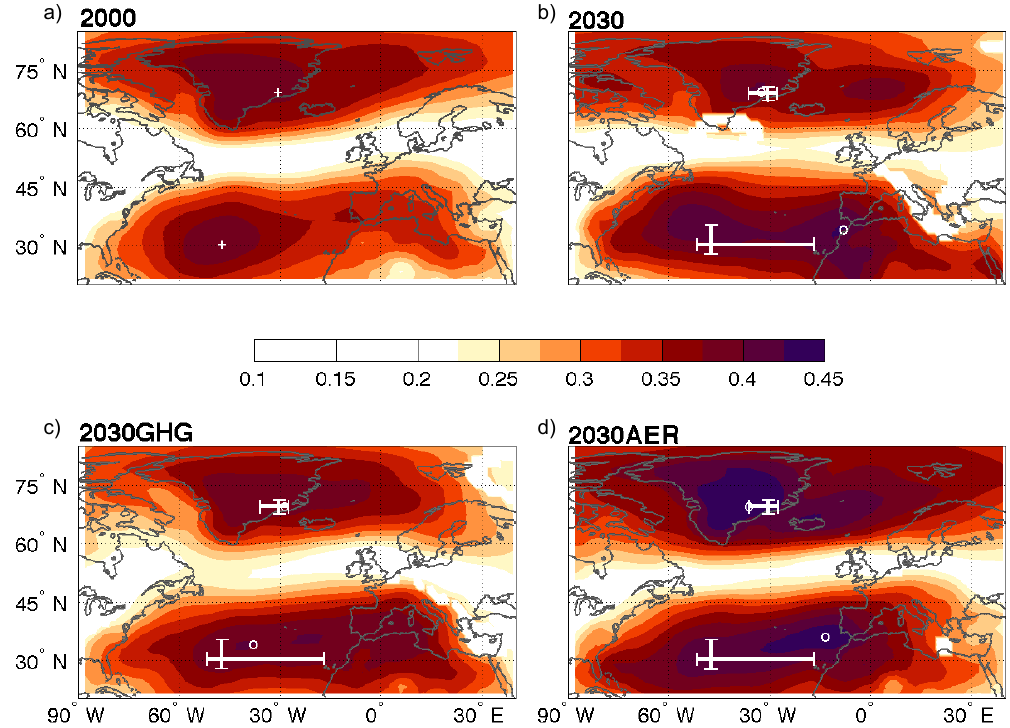
Figure 1. Sea-level pressure coherence index maps of the North Atlantic sector for the 2000 (a) and 2030 (b) simulations and the two sensitivity studies ( c , d ) in winter (DJF). The SLP centres of action (COAs) for the control run and for the 2030 simulations are shown by white crosses and white circles, respectively. The bars delimit the range between the 10th and 90th percentile of the CI maxima in the 2000 simulations. Only areas in which the difference between the 2000 control pattern and the sensitivity simulation is significant at the 95% confidence level and CI values are greater than 0.225 are shaded. The choice of shading only CI values greater than 0.225 is arbitrary.